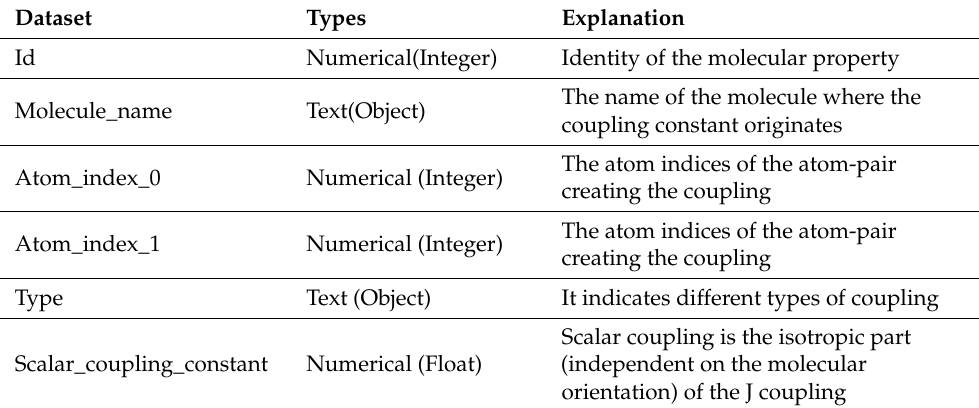
Figure 1. The Scalar Coupling Constant in the Molecular Property. Table 1. Descriptions of